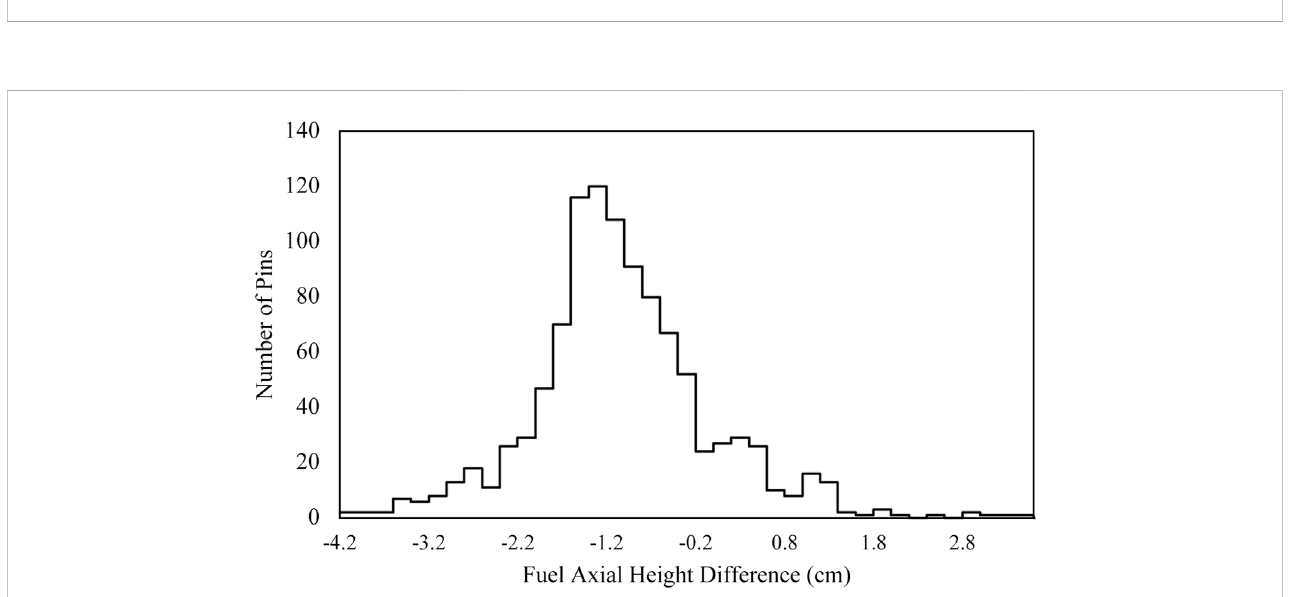
Difference in axial fuel swelling length between BISON and Fuels Irradiation and Physics Database (FIPD subtracted from